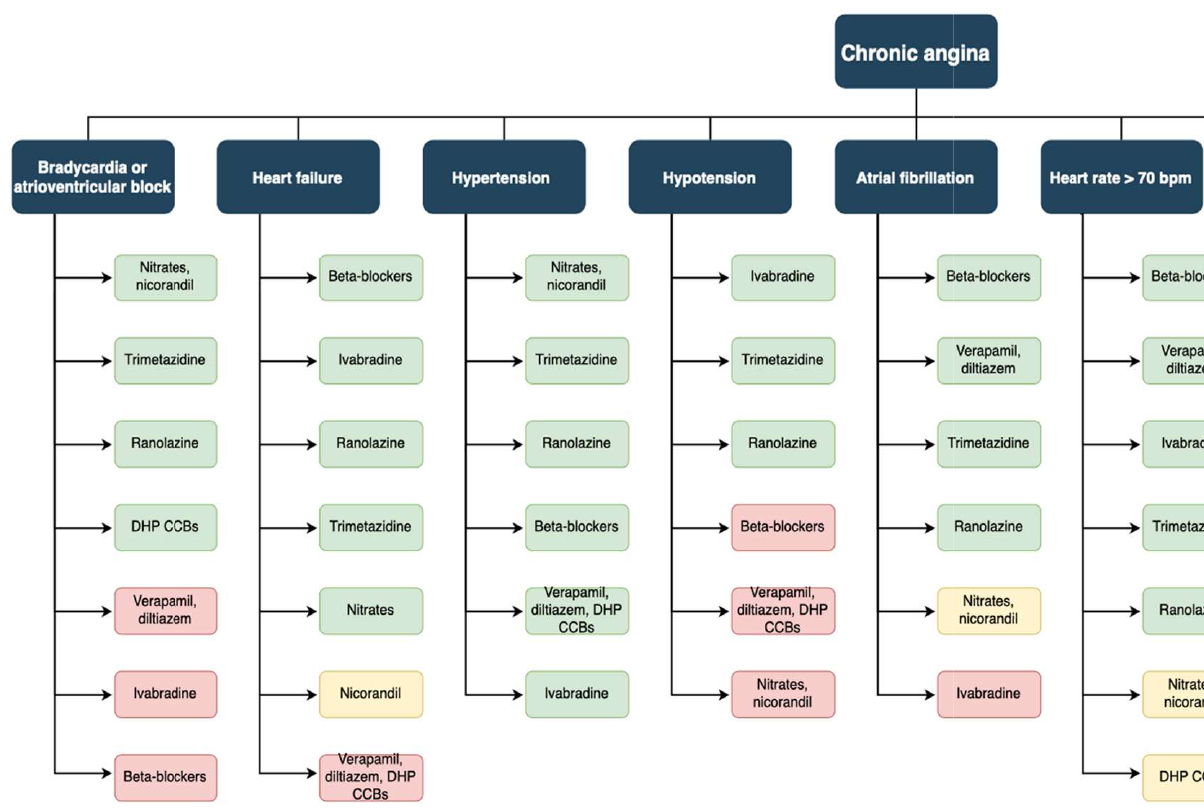
use with caution. Red boxes: generally